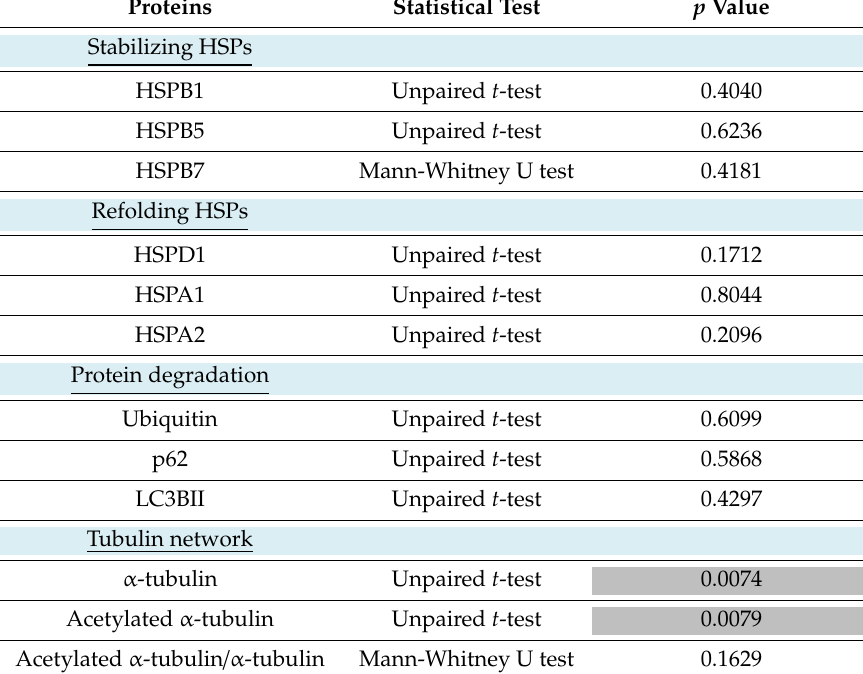
Table 6. Overview of results on statistical testing for di ff erences between HCM HI and HCM PP